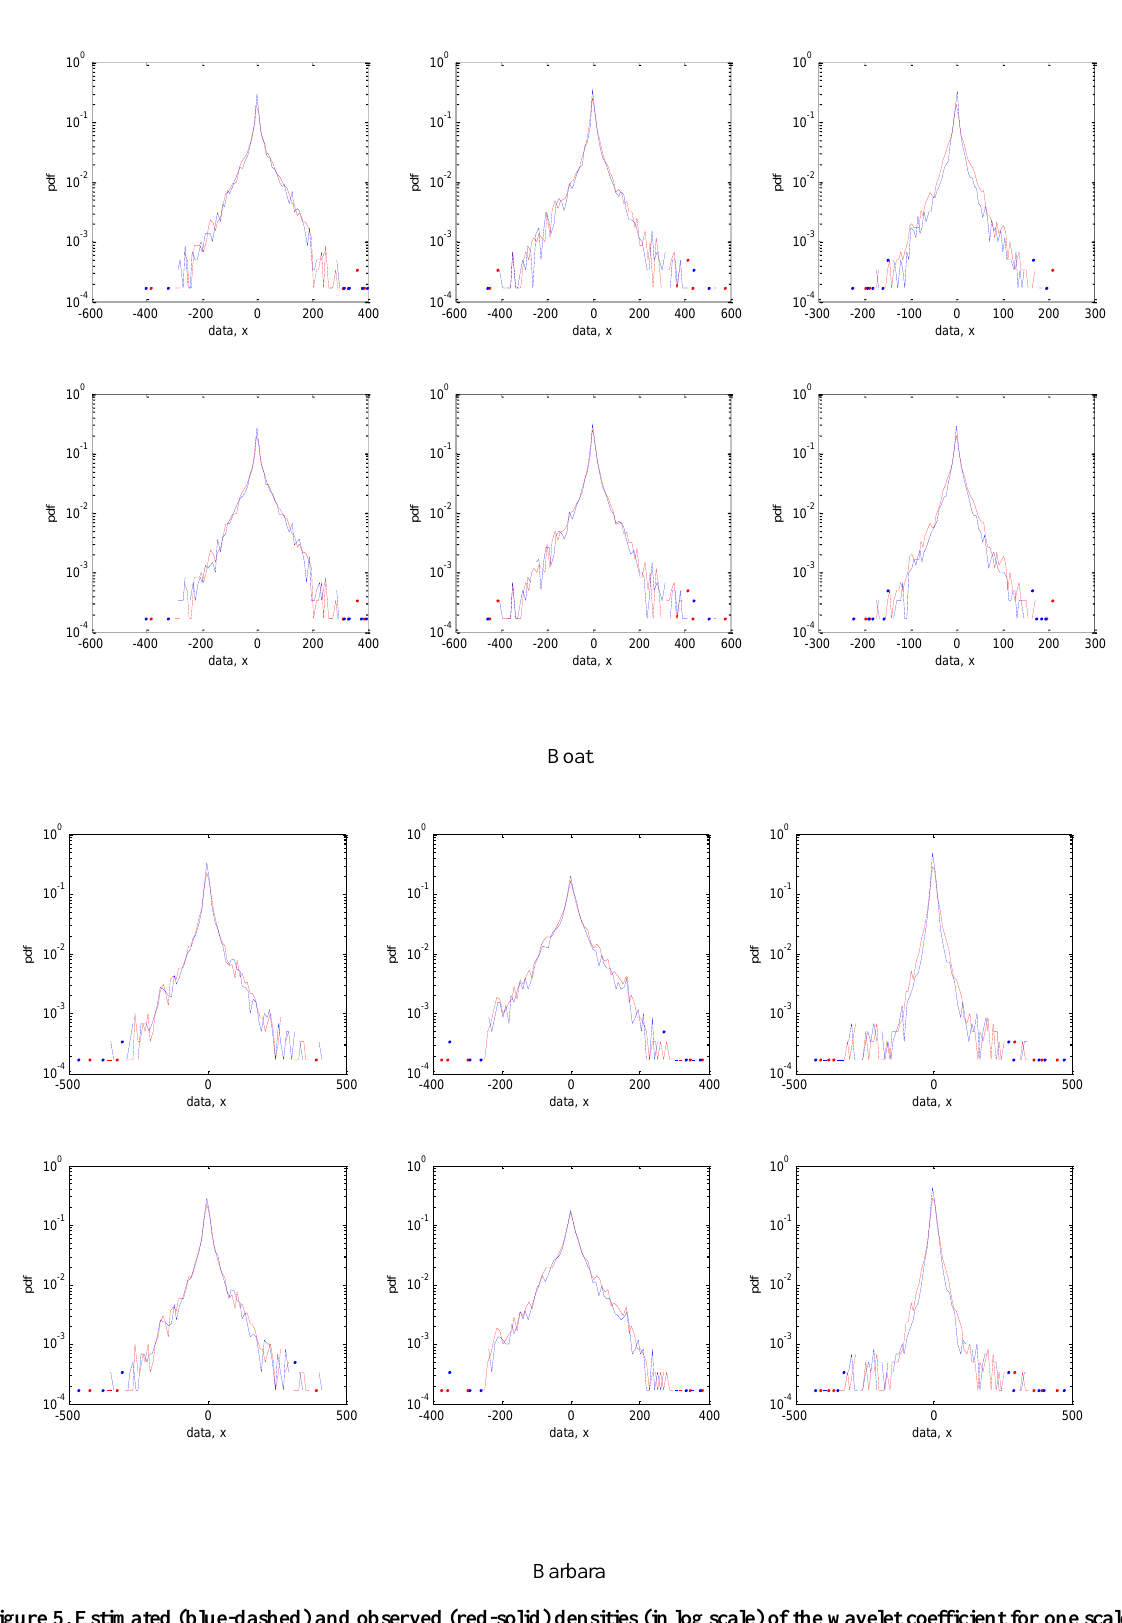
Figure 5. Estimated (blue-dashed) and observed (red-solid) densities (in log scale) of the wavelet coefficient for one scale of the wavelet transform. The first row corresponds to the student 𝒕 model and the second one corresponds to the slash distribution model. The three columns are HH , HL , and LH